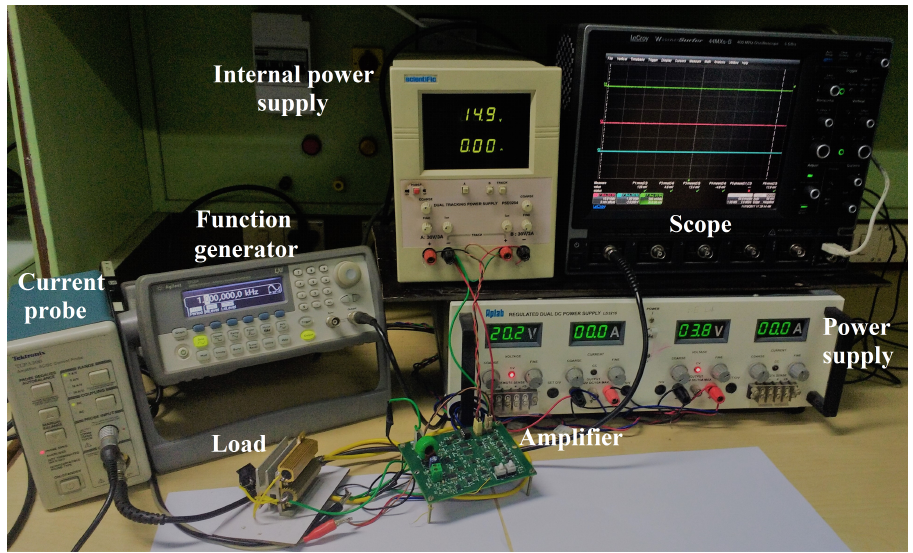
Figure 12. Experimental setup.